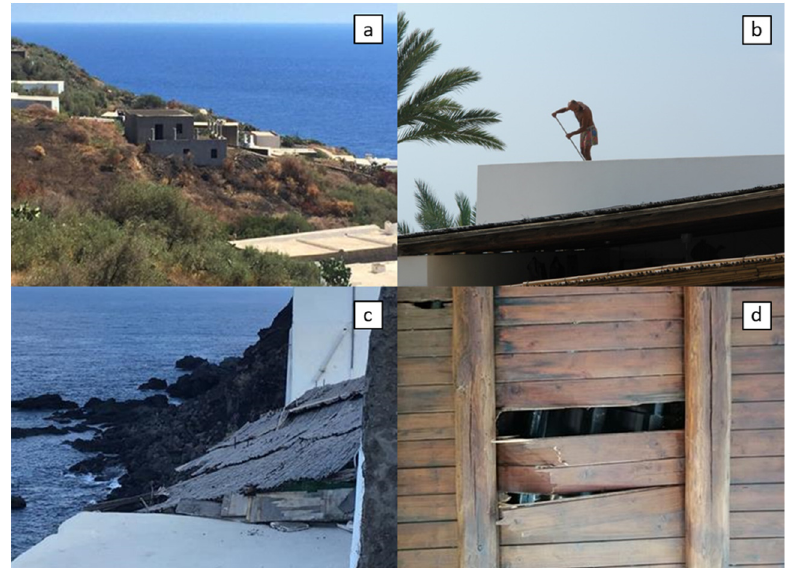
Figure 8. Tephra accumulation on the roofs in ( a ) and ( b ), damages to the canopies in ( c ) and ( d ) at Ginostra, following the 3 rd July 2019 paroxysmal explosion.